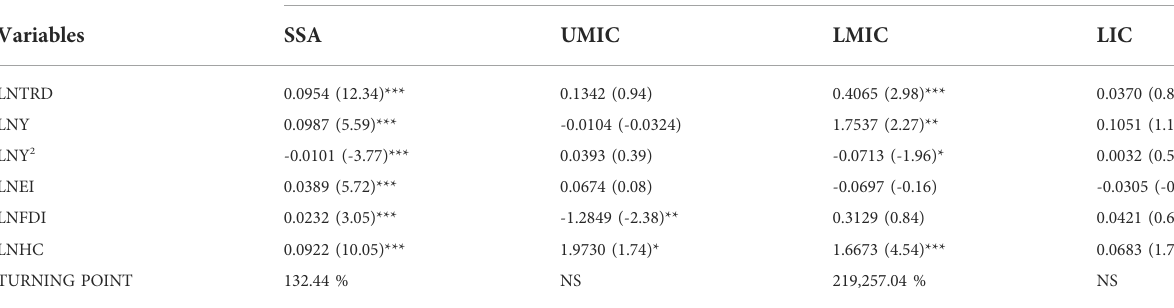
TABLE 6 Environmental Kuznets Curve (EKC)